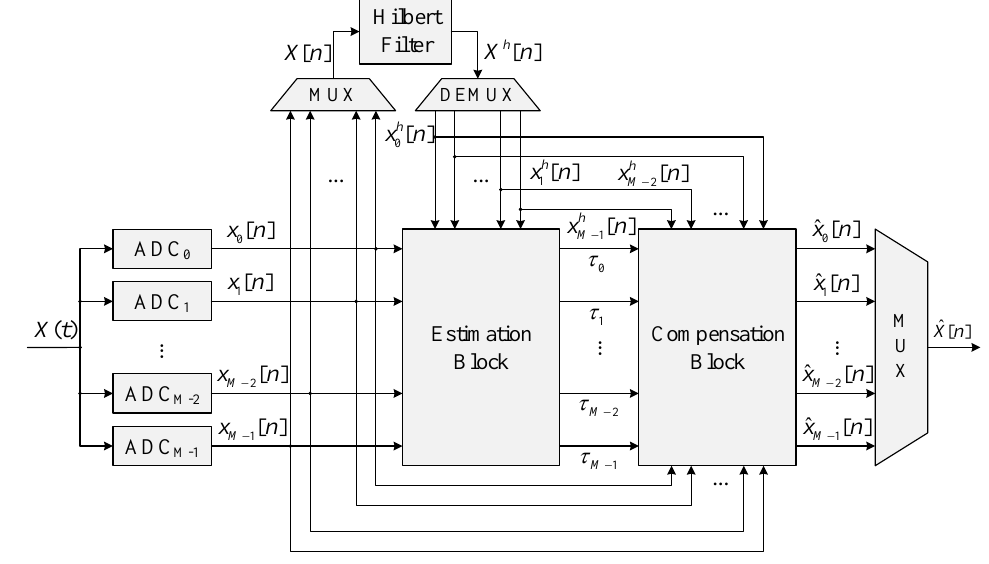
Figure 3. The overall block diagram of the proposed timing-mismatch calibration